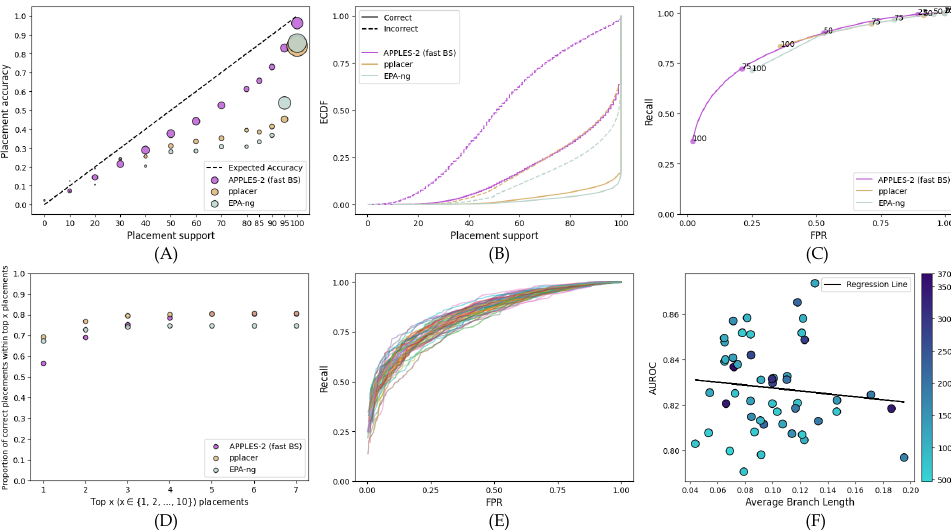
Figure 5. Results for the WOL dataset’s placement of each gene on its corresponding gene tree . In ( A – D ), we treat each gene as a replicate and show the combined results of the 50 genes. We also analyze each gene individually. The settings for the subfigures ( A – D ) are similar to Figure 1. ( E ) ROC curve shown separately for each gene. ( F ) AUROC for each gene versus the average branch length in the corresponding gene tree.